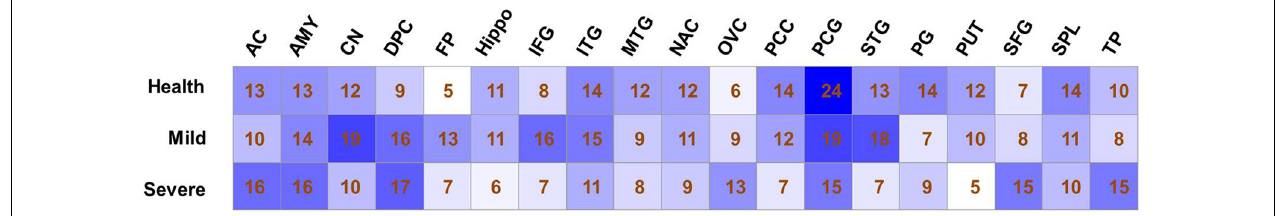
FIGURE 1 | Modules number of co-expression networks in different sample sets. The number of co-expression modules that identified by Weighted gene coexpression network analysis analysis is shown for each sample set.